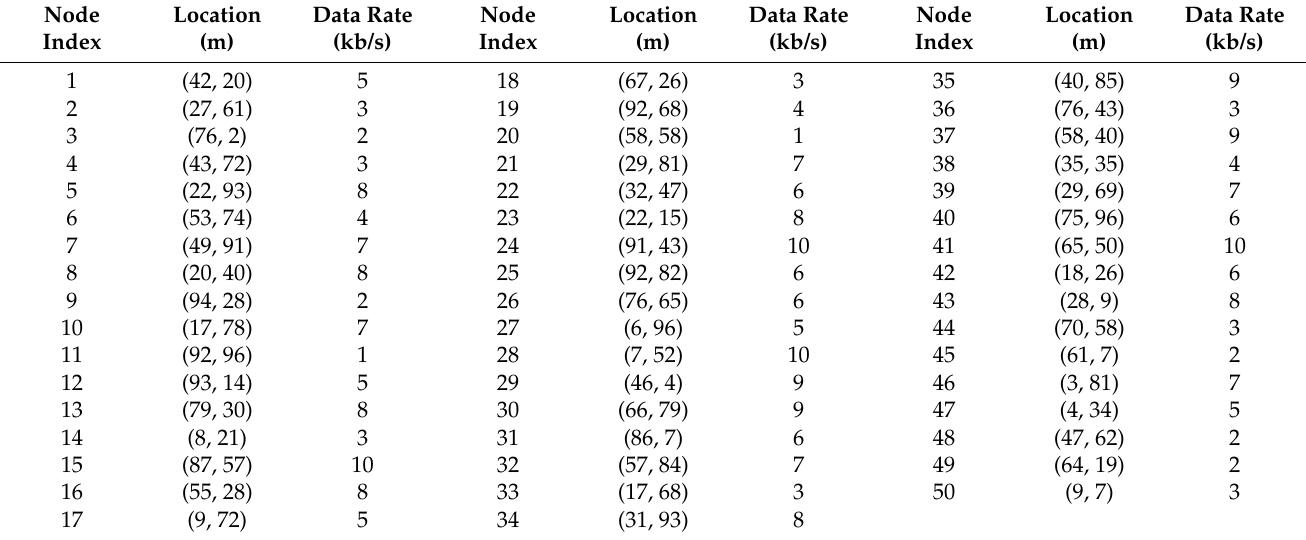
Table 2. Location and data rate for each node in a 50-node